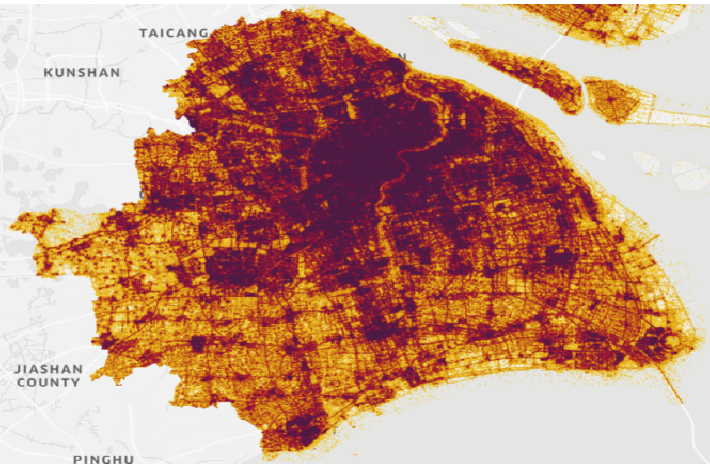
Figure 7. The passenger flow dataset of Shanghai, where red refers to high-density